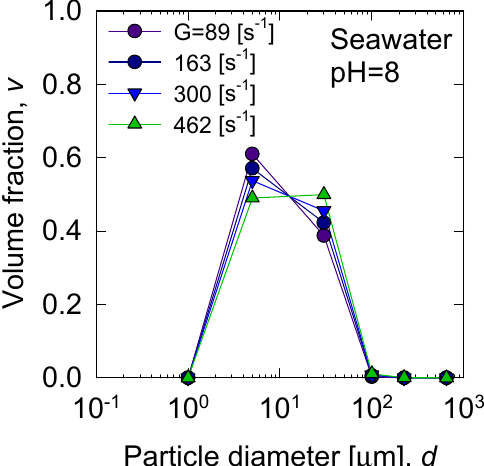
Figure 1. Normalized initial volume distribution of particles of synthetic tailings in seawater at pH 8 for di ff erent mixing intensities (shear rate G).